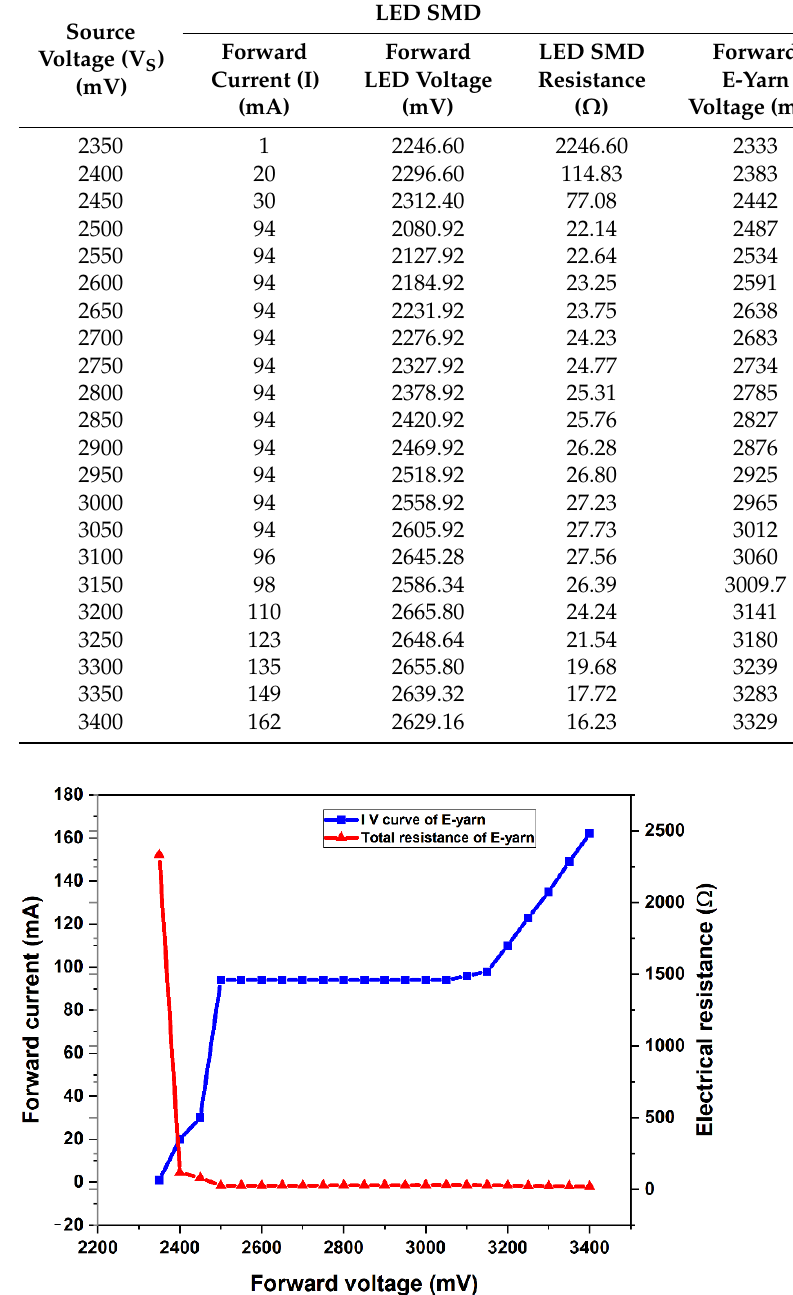
Figure 7. Current–voltage characteristic curve and total resistance of the